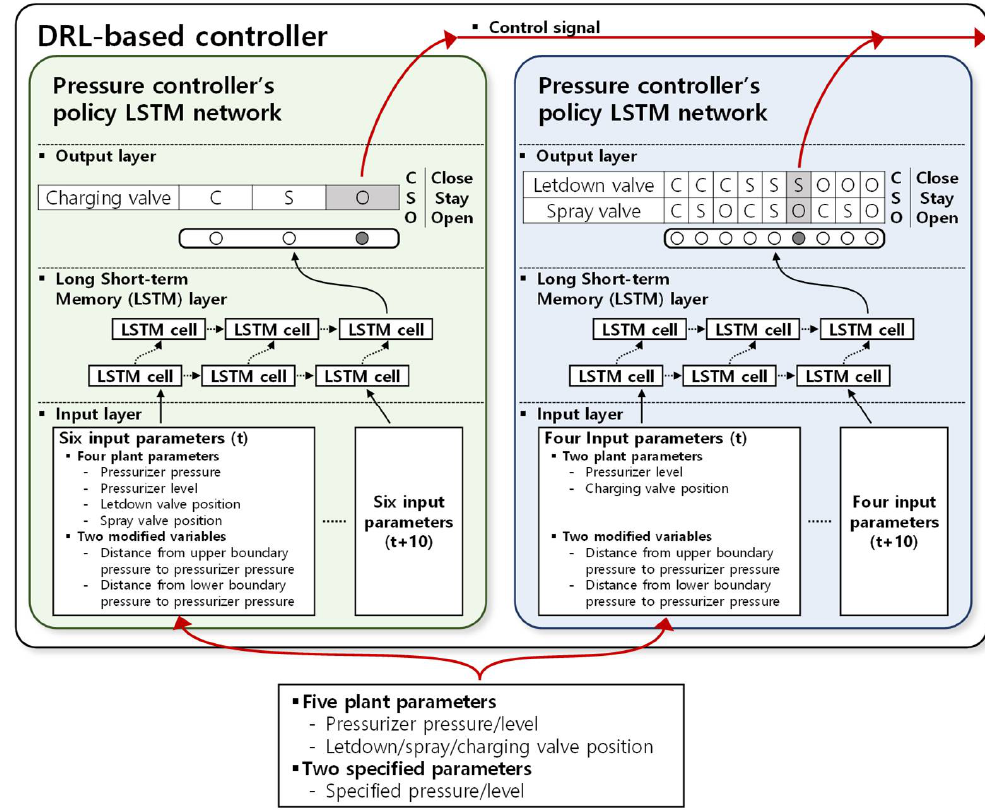
Figure 9. Structure of LSTM network for the DRL controller policy network.